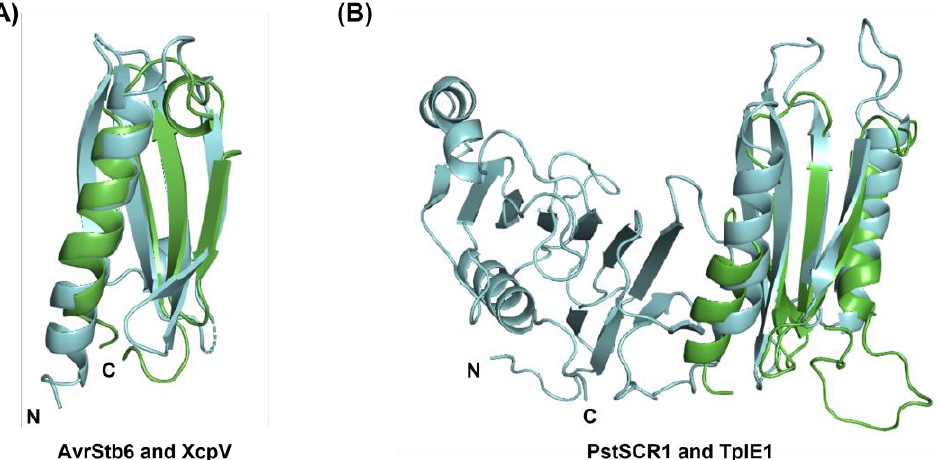
Figure 10. Superimposition of the final models of AvrStb6 ( A ) and PstSCR1 ( B ) with the structures of XcpV of T2SS and TplE1 of T6SS, respectively. Rosetta models are coloured in green and homologous structures in cyan.